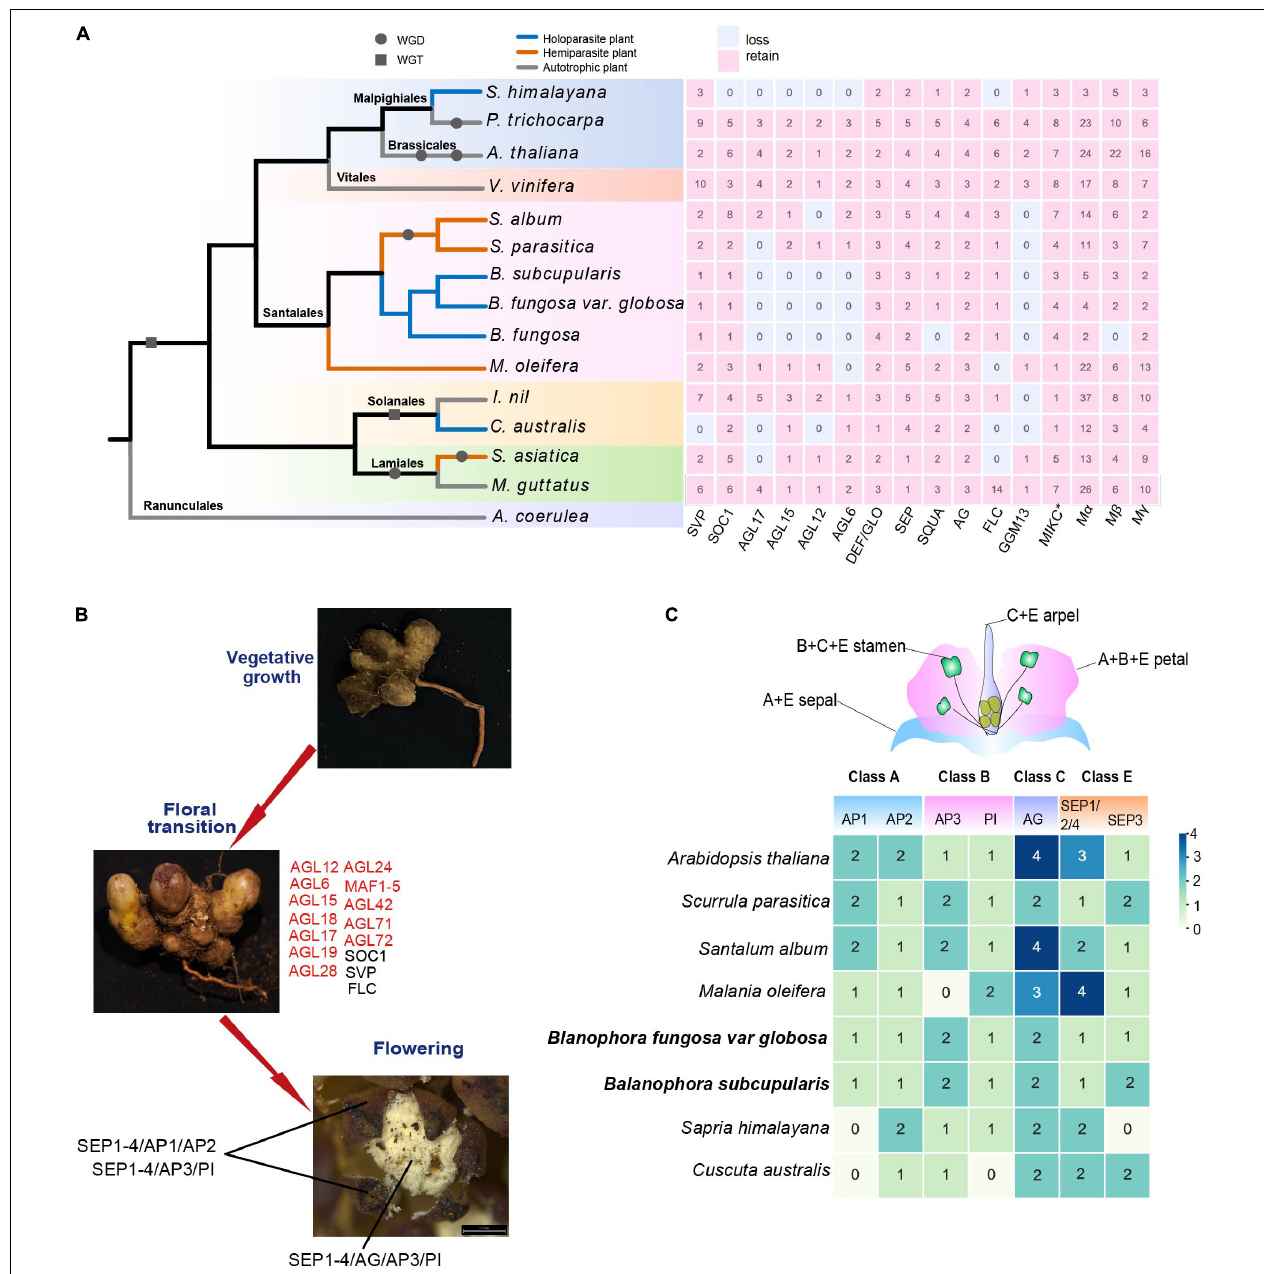
FIGURE 4 | Gene loss of MADS-box genes in parasitic plants. (A) The gene loss and retention of 16 subgroups of MADS-box gene family in nine parasitic plants. The tree topology is modified from Nickrent (2020) with Aquilegia coerulea as outgroup, 14 species comprising seven orders (see Supplementary Table 1 ). The gray circle and square indicate WGD (whole genome duplication) and WGT (whole genome triplication) events, respectively, which were identified by 1KP (Leebens-Mack et al., 2019). The pink and white blocks indicate retain and loss of MADS-box genes in 16 subgroups, respectively. The green, blue, red branches represent autotrophic plants, hemiparasites, and holoparasites, respectively. (B) Gene loss of MADS-box genes in flowering transition. Genes marked in red represent loss and black represent retained genes in B. subcupularis and B. fungosa var. globosa. (C) A conventional flower structure of ABCE model genes. The numbers represent retained ABCE model genes in B. subcupularis , B. fungosa var. globosa , and reference species, while the numbers are obtained based on the phylogenetic